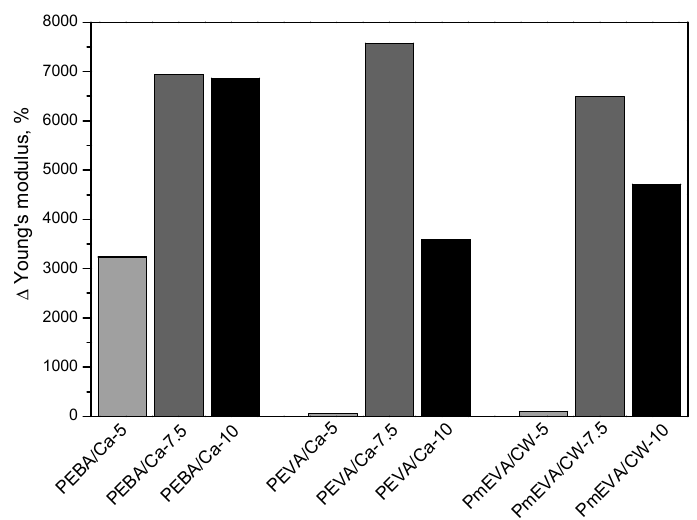
Figure 4. Influence of a MMT pre-dispersion type and MMT content (5, 7.5 or 10 wt. %) on Young’s modulus value of PE composites.